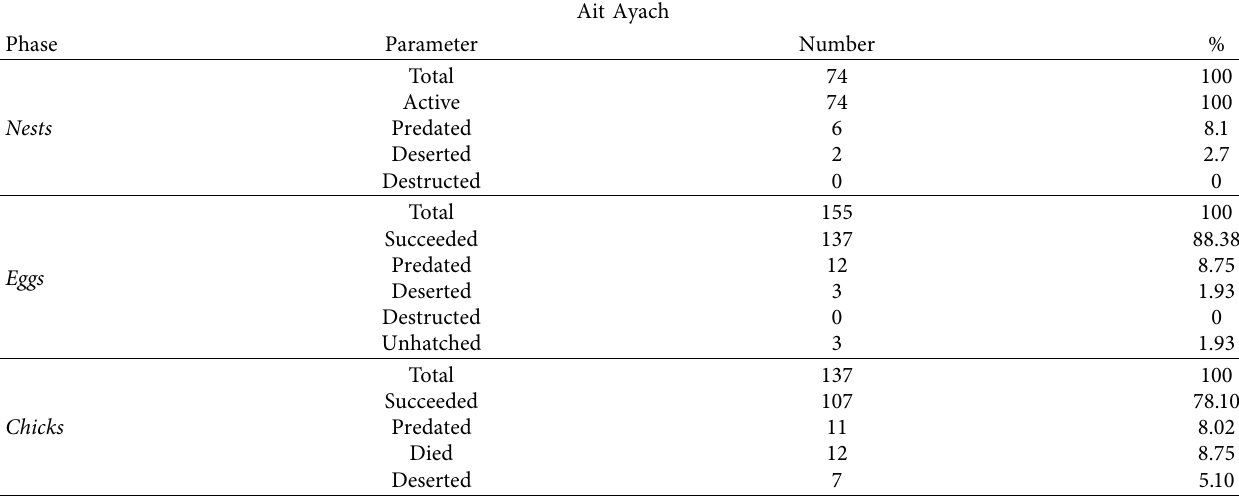
Table 3: Breeding success and failure factor between breeding phases of the Blackbird at Ait